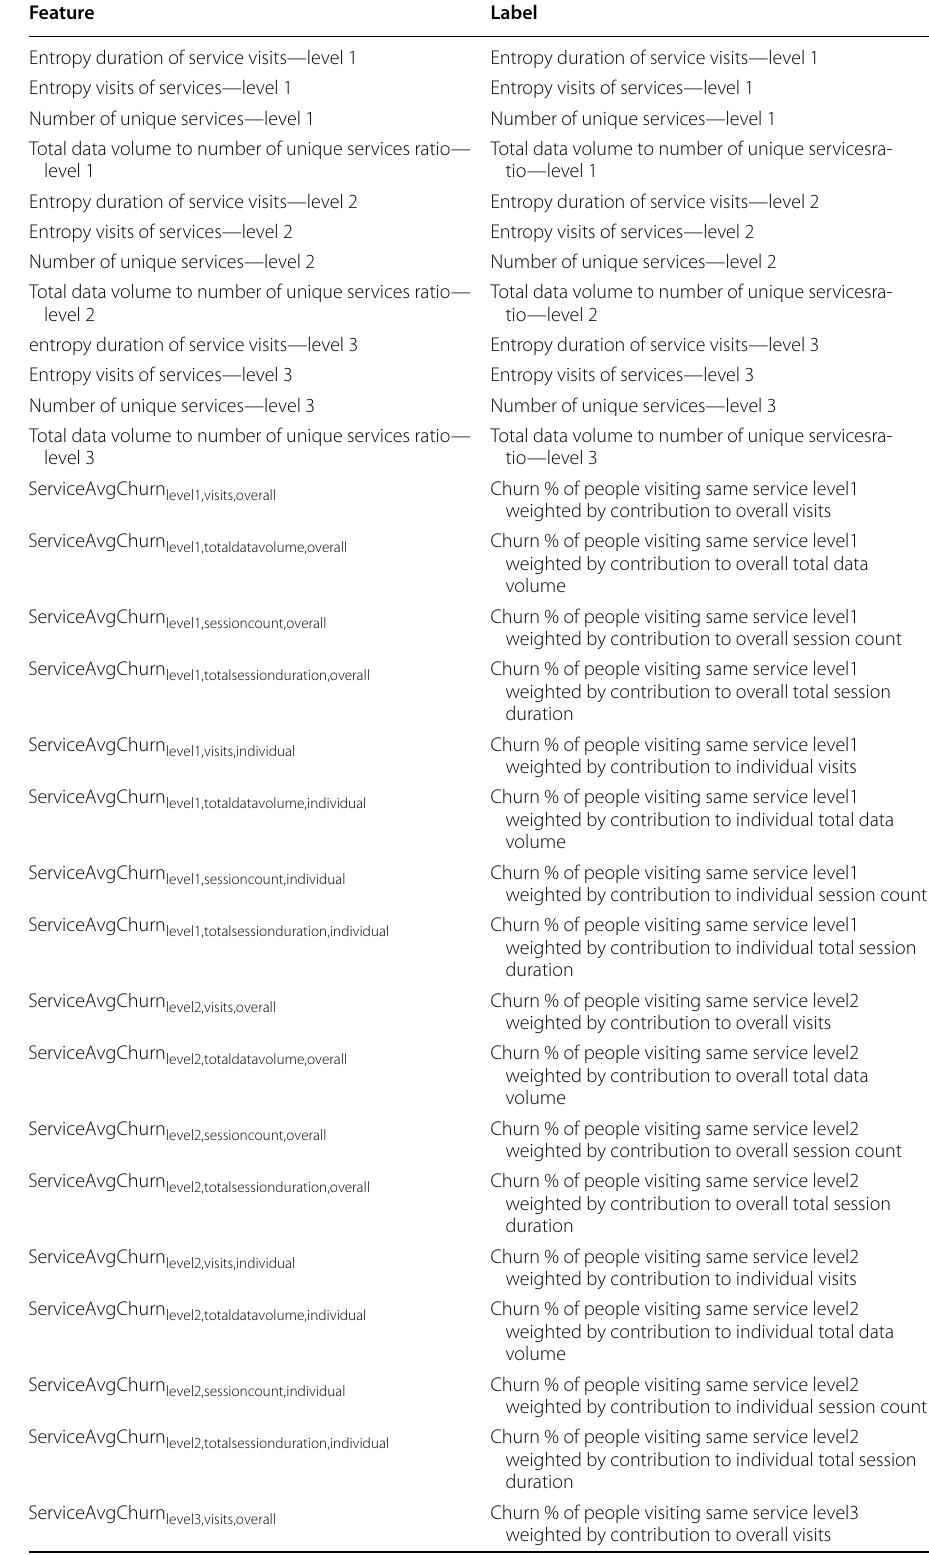
Table 3 Service